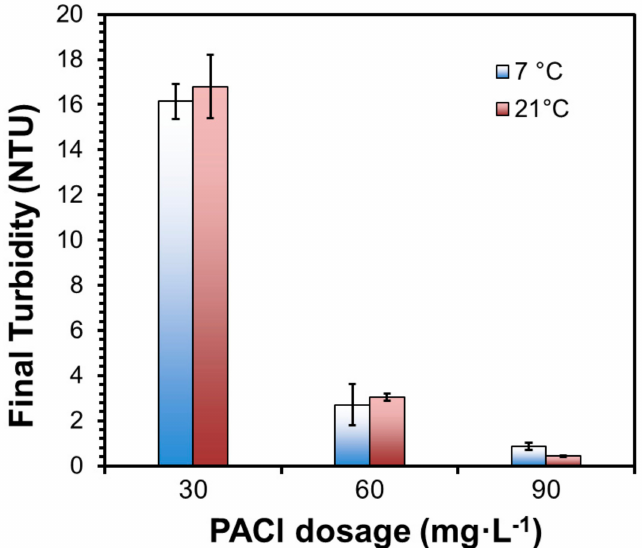
Figure 5. Turbidity removal at 7 ◦ C and 21 ◦ C with three PACl dosages. (Initial pH = 7.47, initial turbidity = 70.00 NTU, initial TOC = 6.14 mg · L − 1 ; data plotted as mean of duplicates and error bars calculated as standard deviation to indicate data